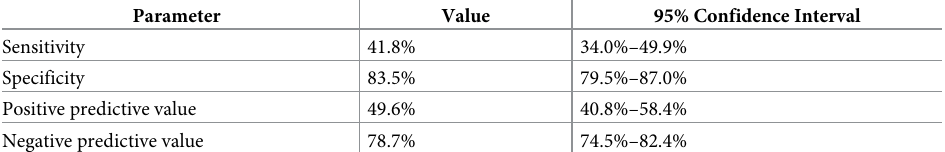
Table 4. Diagnostic parameters of low IgG avidity (regardless of other tests) upon confirmation or exclusion of acute